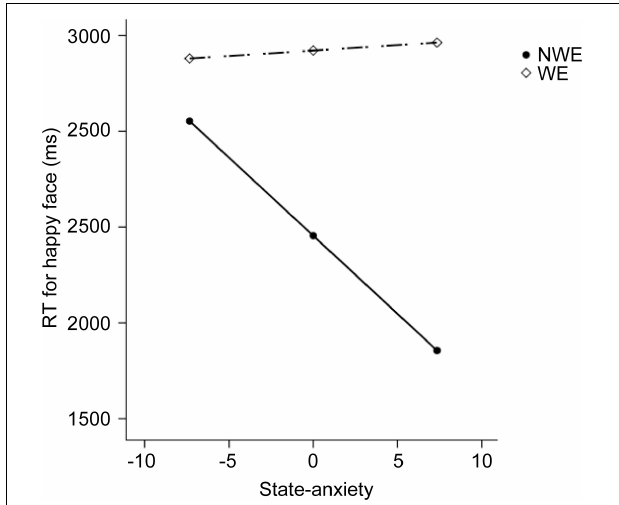
FIGURE 1 | The moderation effect of state anxiety on the relationship between widowhood and the performance in the visual search experiment. The dependent variable here is the reaction time (RT) for happy faces at the set size of 8. NWE, non-widowed elderly; WE, widowed elderly.